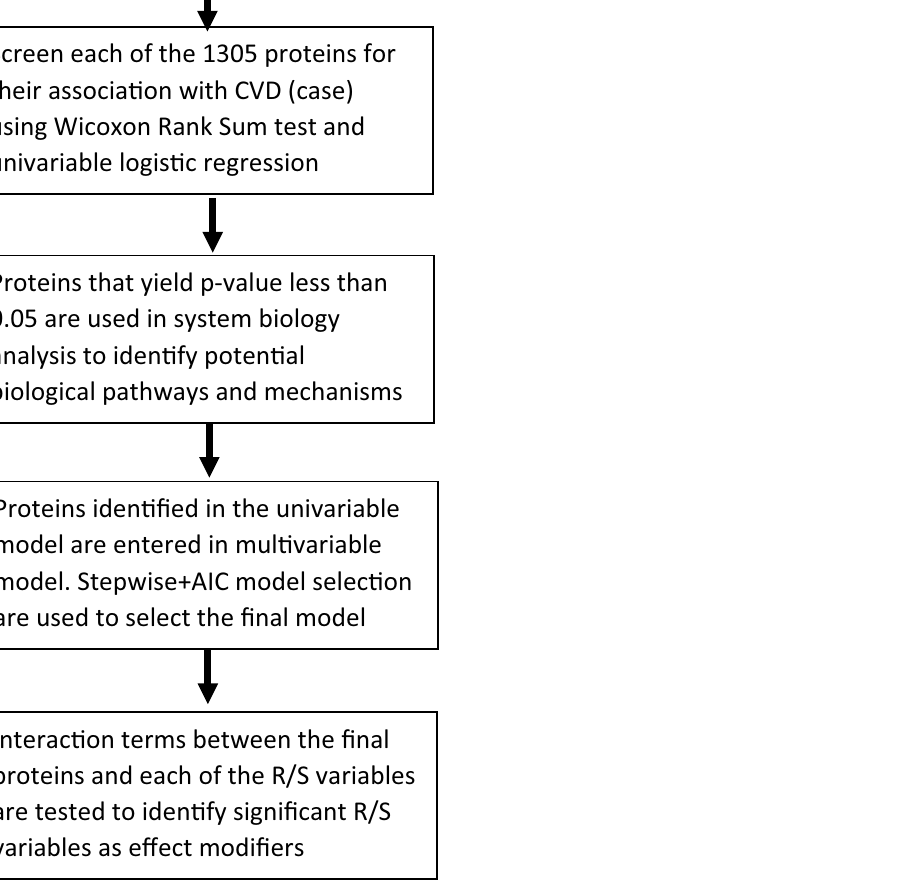
Figure 1. Analysis flow